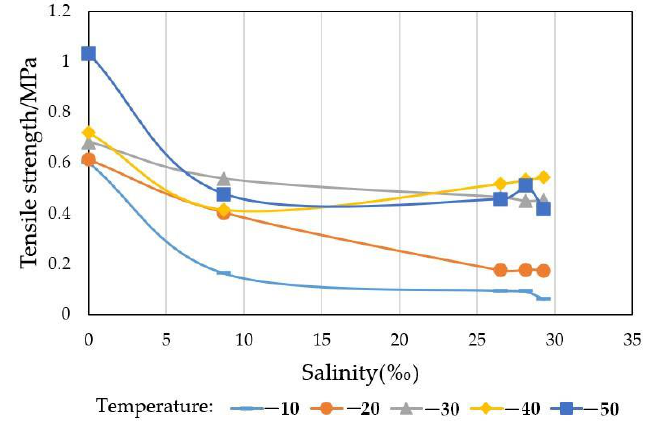
Figure 25. Tensile strength and salinity.